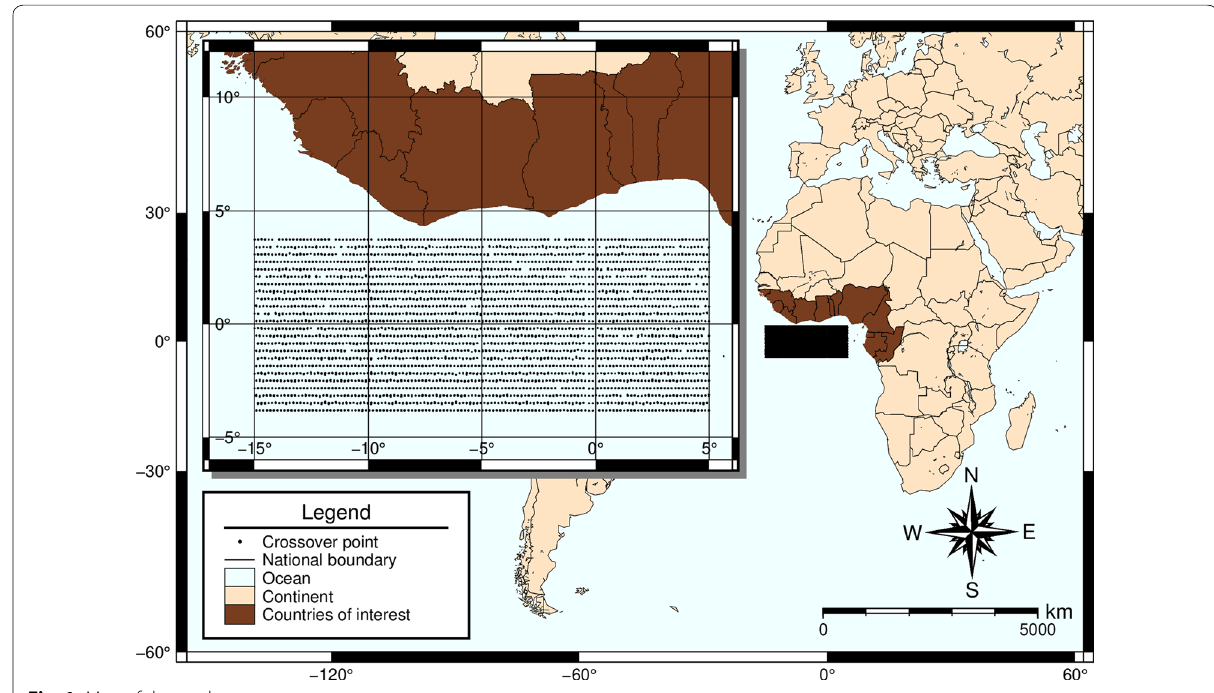
Fig. 1 Map of the study